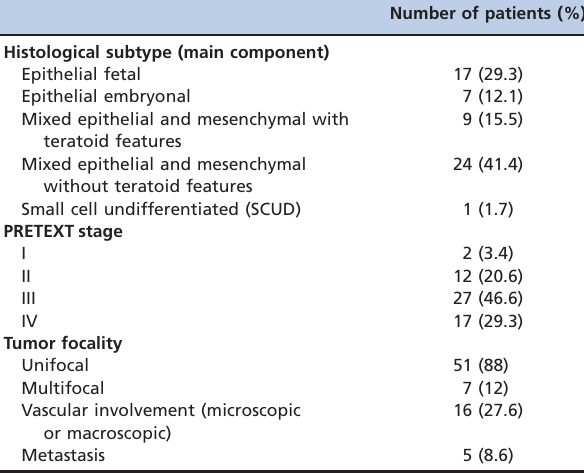
Table 1 - Main patient characteristics at the time of hepatoblastoma diagnosis.